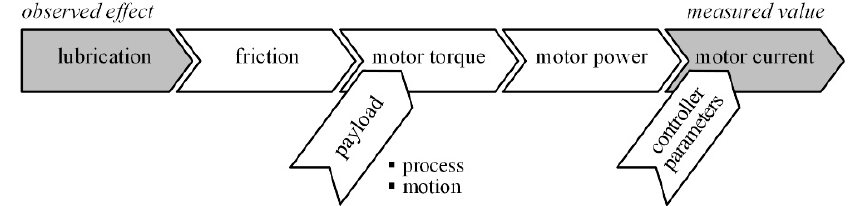
Figure 7. Cause–effect chain between lubrication states which is to be detected and measured value.